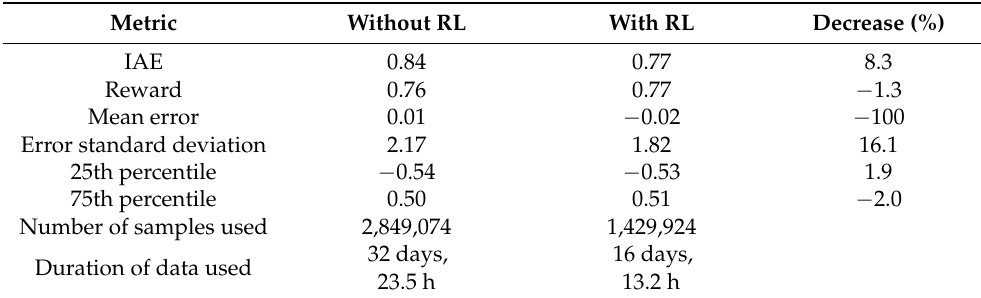
Table 5. Mill inlet water control loop performance with and without RL. The decrease percentage measures the decrease in the absolute value of the metric owing to the use of RL. Positive decreases indicate better performance, except for the reward, where an increase is expected.